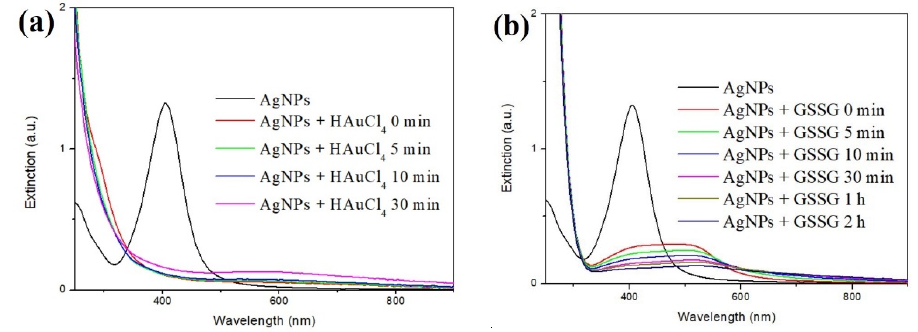
Figure 5. ( a ) Time course detection of UV-Visible spectrophotometer for the Au NCs synthesis. ( b ) Time course detection of UV-Visible spectrophotometer for the association of GSSG with Ag